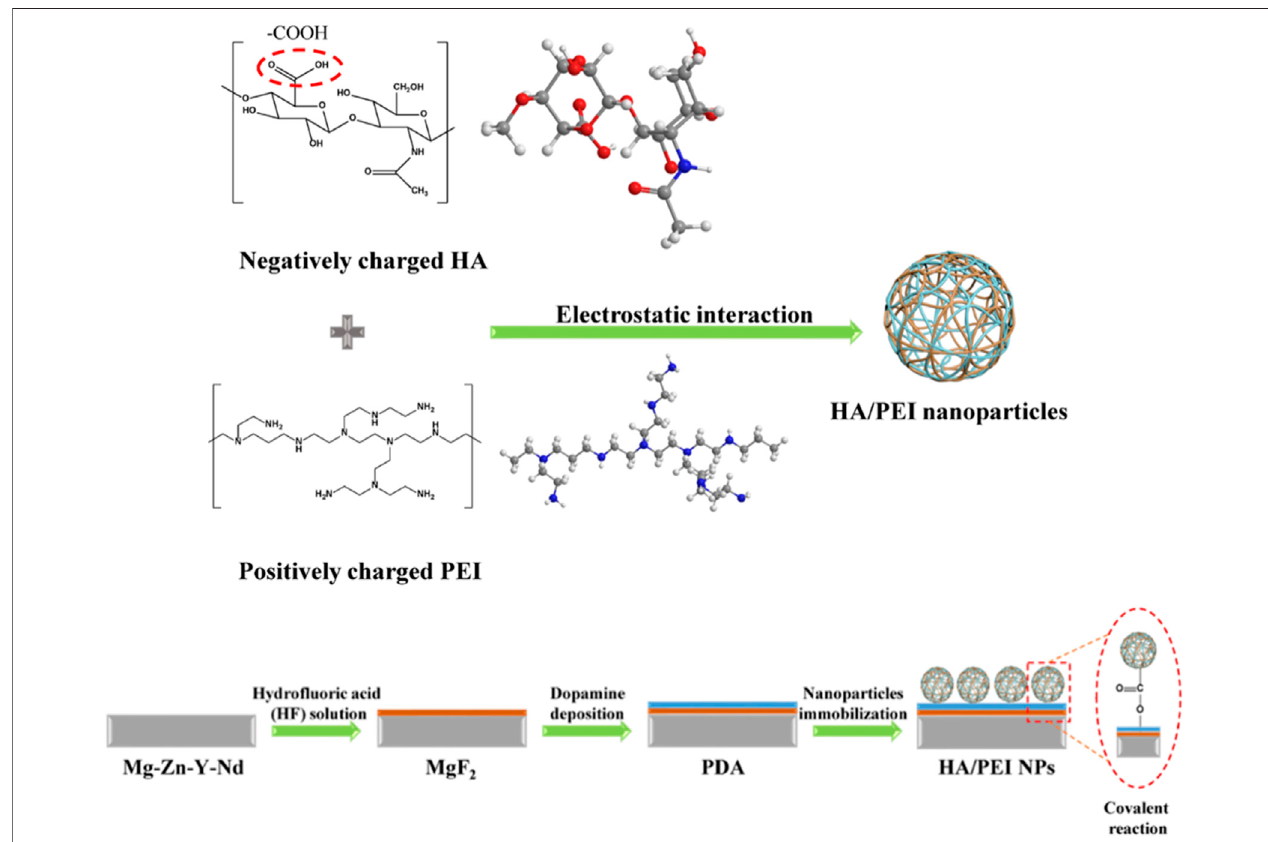
FIGURE 4 | Surface modi fi cation of the Mg alloy with HA nanocomposite coating: nanoparticles prepared with HA and polyethyleneimine (PEI) by electrostatic interaction were conjugated onto the Mg-Zn-Y-Nd alloy which was pre-treated with hydro fl uoric acid and dopamine solution (Li et al., 2021b).